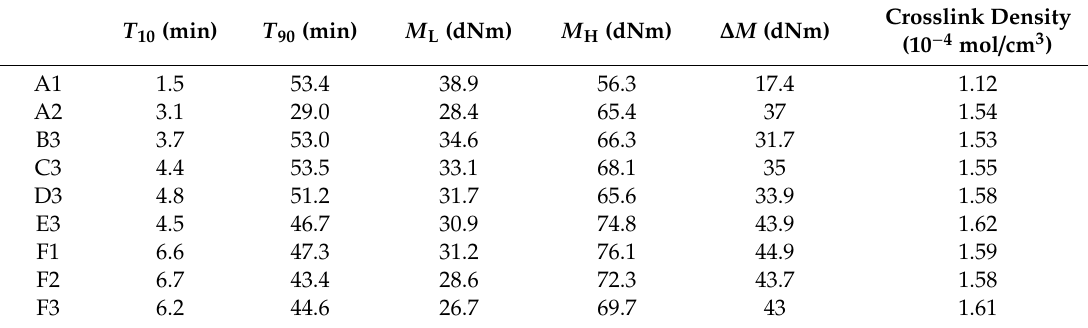
Table 5. Curing behavior of silica / SSBR / BR